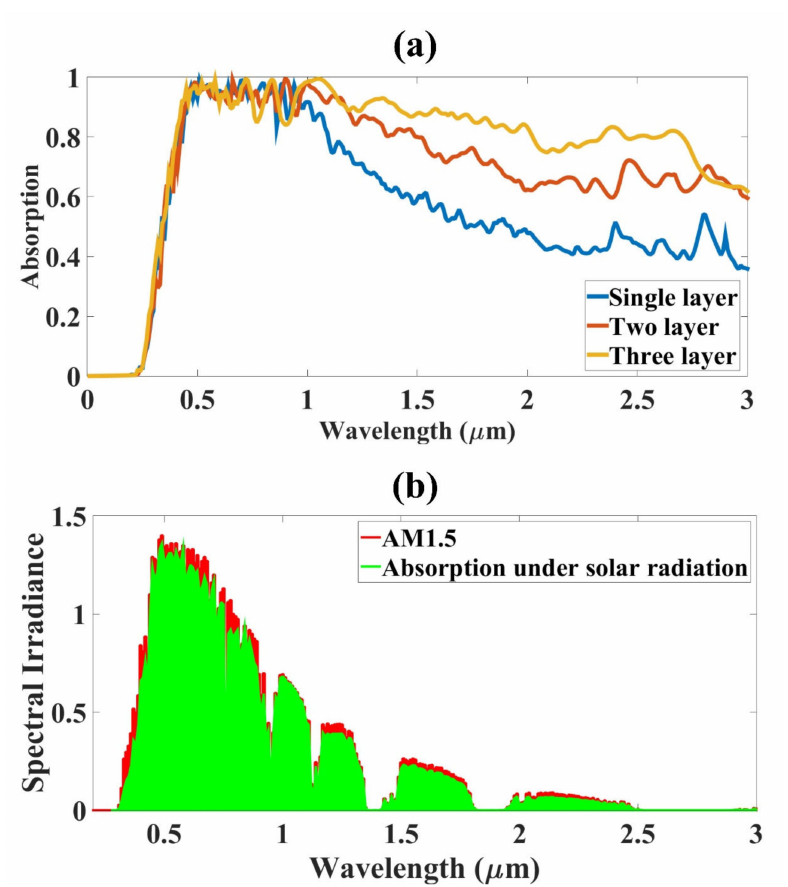
Figure 2. ( a ) Comparison of absorption results of single-layer design, two-layer design, and three- layer design is giving high absorption compared to the other two designs. The three-layer design ( b ) AM 1.5 results comparison with three-layer design results. The green color plot shows the absorption in the AM 1.5 response in W m − 2 µ m − 1 . The red color shows the energy of AM 1.5 not absorbed through the